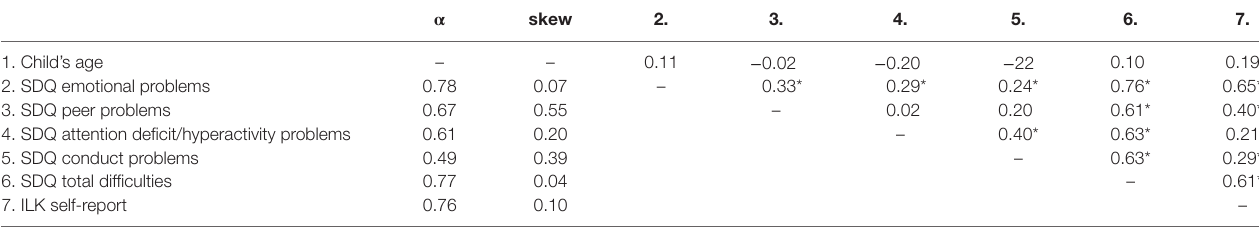
TaBle 1 | Reliabilities and bivariate relationships of study